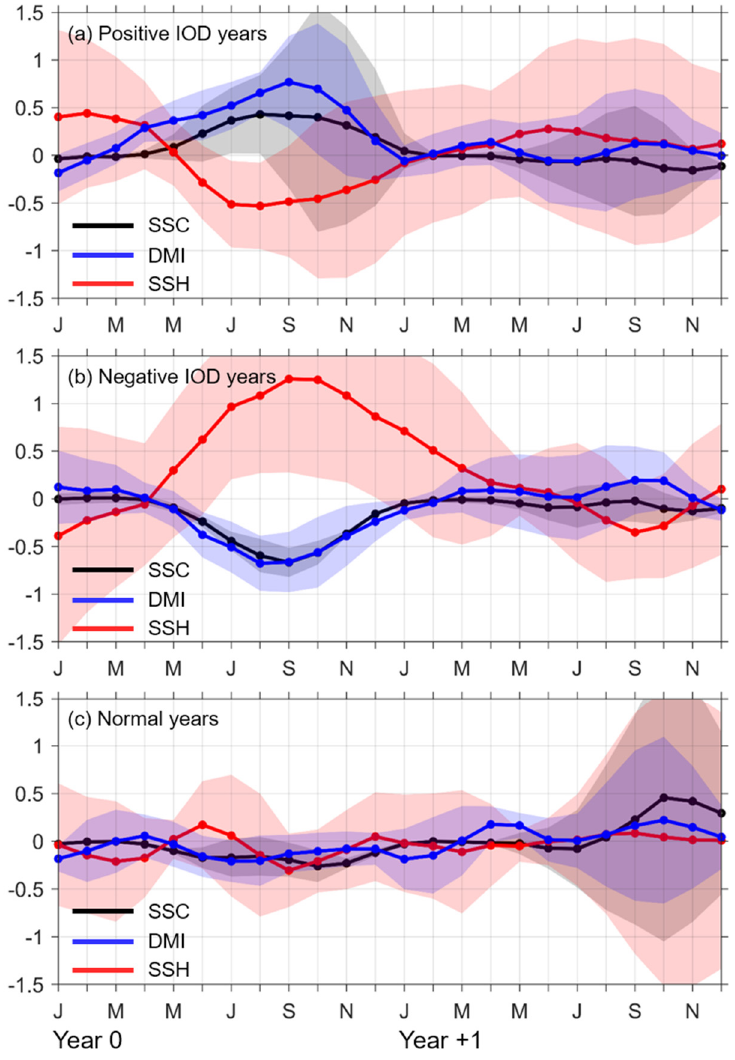
Figure 11. Composite SSC, DMI, and SSH during ( a ) positive IOD; ( b ) negative IOD; and ( c ) normal and following years. Year 0 and Year +1 refer to the IOD events and the following years, respectively. The unit of SSH is 10 − 1 m. Light shadings in ( a – c ) indicate the standard deviation of the composite SSC (gray), DMI (blue), and SSH (red).